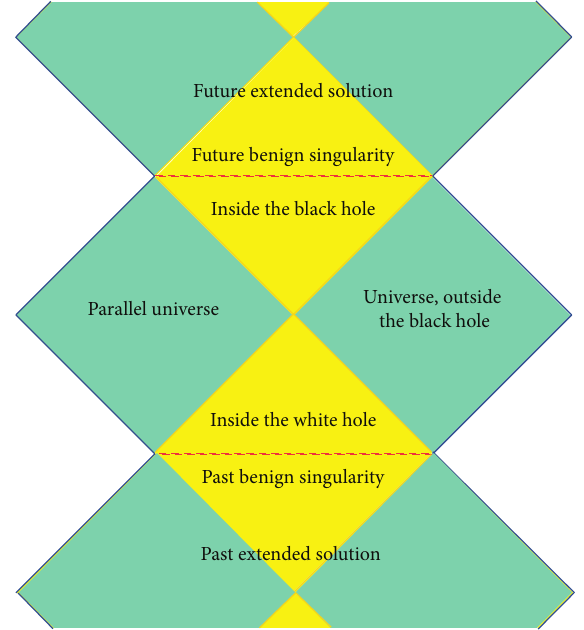
Figure 1: Schwarzschild solution, analytically extended beyond the 𝑟 = 0